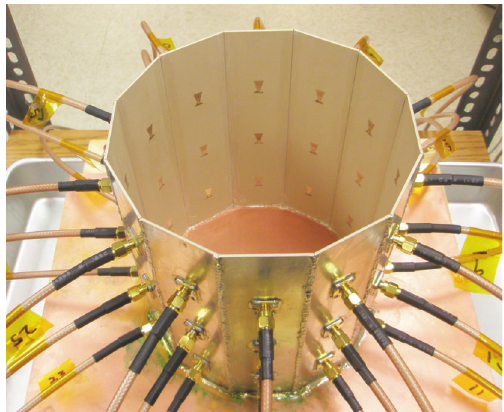
Figure 3: Imaging cavity. Twelve panels with three bow-tie antennas each are solder together and to a conducting plate.